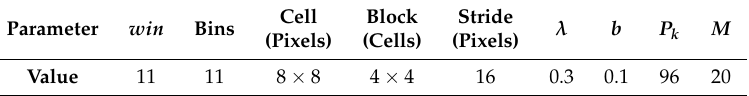
Table 3. The parameters used in the proposed